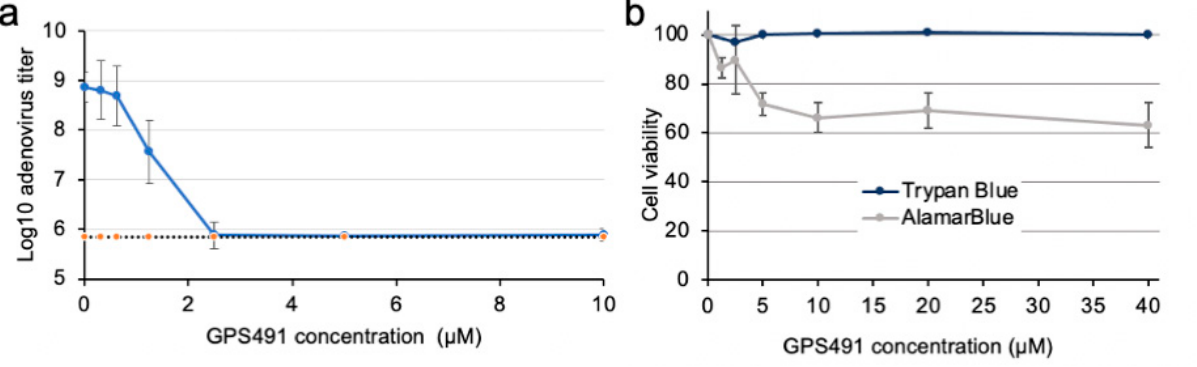
Figure 3. GPS491 inhibits adenovirus (HAdV-C5) replication in A549 cells. ( a ) A549 cells were uninfected or infected with human adenovirus serotype 5 (HAdV-C5) at an input MOI of 100 IU/cell for 1 h after which the virus inoculum was removed and replaced with media containing DMSO or the indicated concentrations of GPS491. After 24 h, the virus was harvested by scraping cells into the culture fluid and the cell suspension was collected for titration of infectious virus by endpoint dilution (blue line). T0 (dotted line, orange dots) is a sample harvested immediately after the 1 h adsorption period to measure the residual virus from the inoculum. Error bars represent the standard deviation of three independent experiments. ( b ) A549 cells were treated with the indicated doses of GPS491 for 24 h and then assessed for changes in metabolic activity by alamarBlue (grey line) or for viability by staining with trypan blue (blue line).